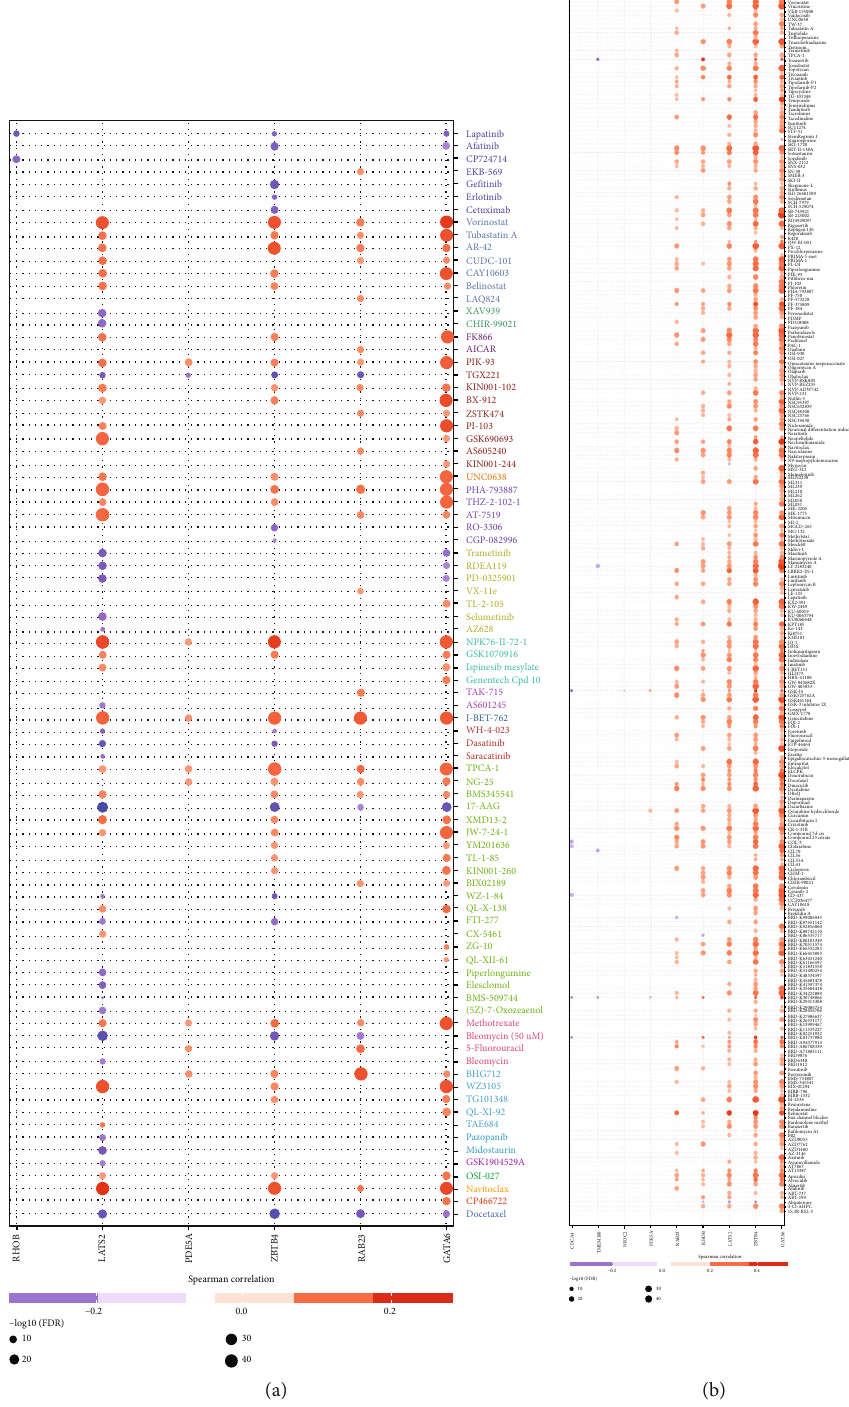
Figure 13: Results of drug sensitivity analysis of the outstanding hub